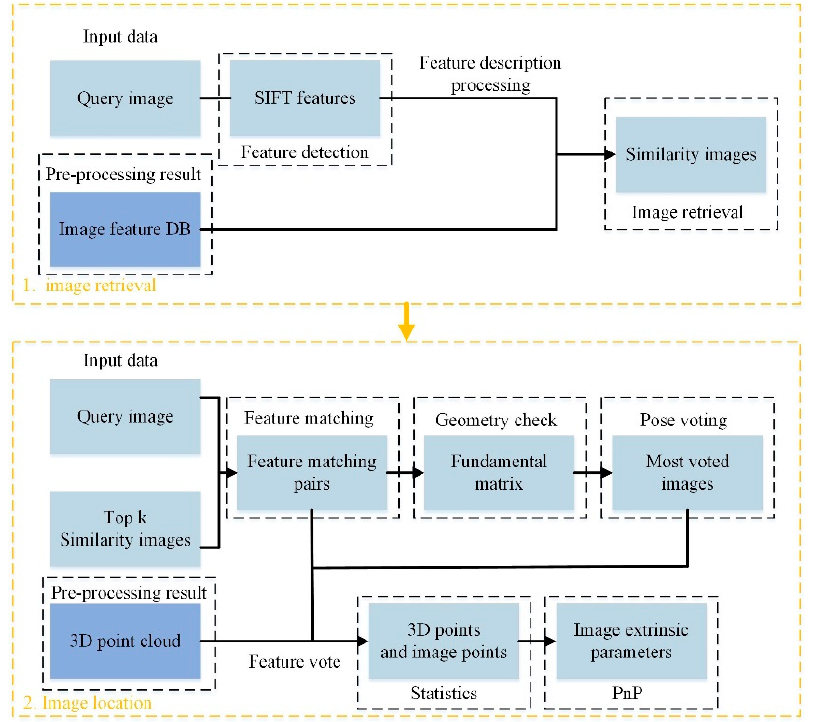
Figure 4. Workflow of smartphone image positioning.